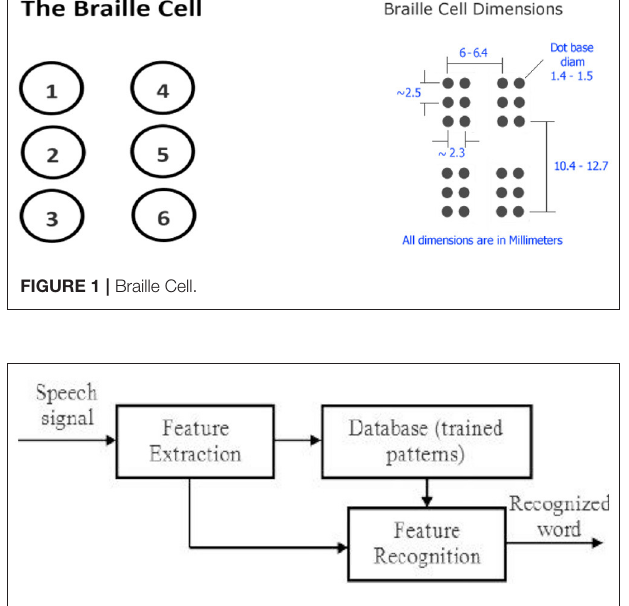
FIGURE 2 | Automatic Arabic speech recognition